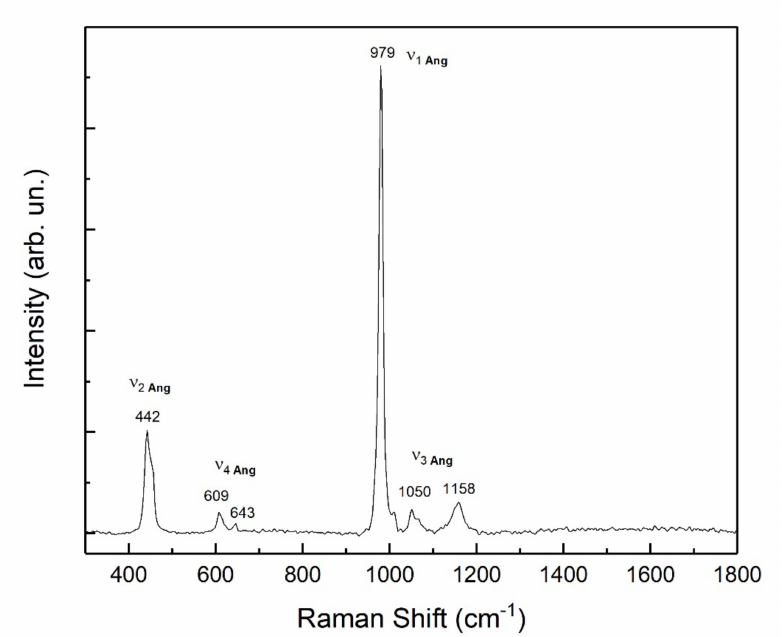
Figure 6. Raman spectra of the precipitate formed in the bulk of a Pb-bearing solution ([Pb] i = 10 mM) during its interaction with gypsum crystals. All bands can be assigned to the vibration modes of